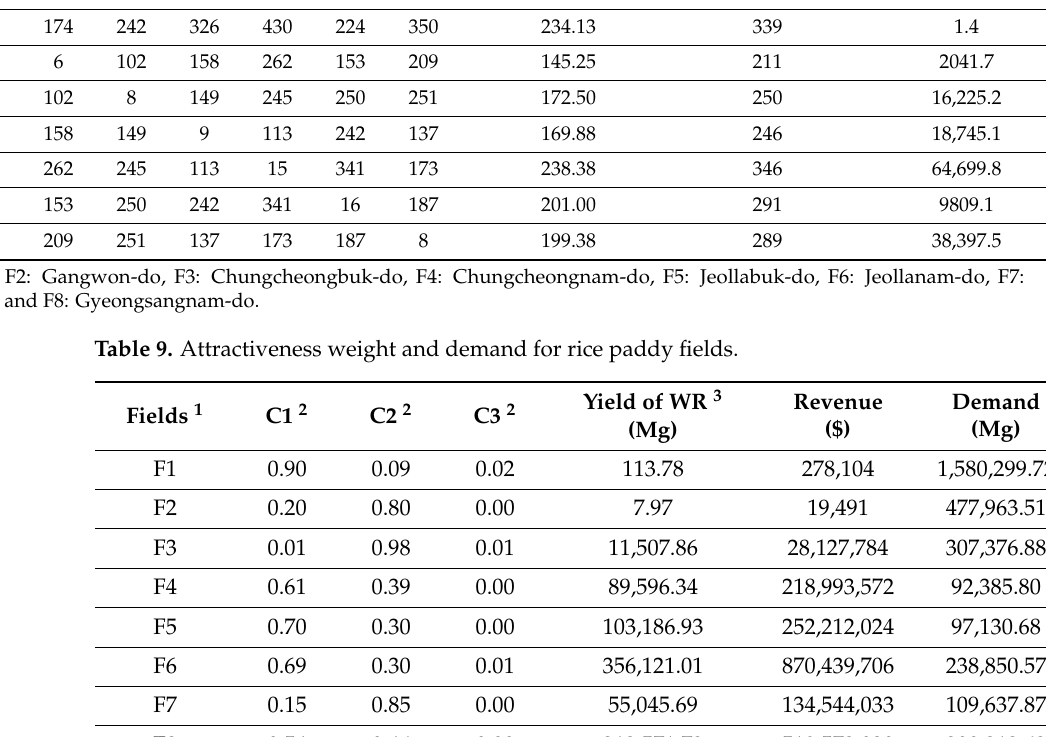
cultivar group 3. 3 WR: white